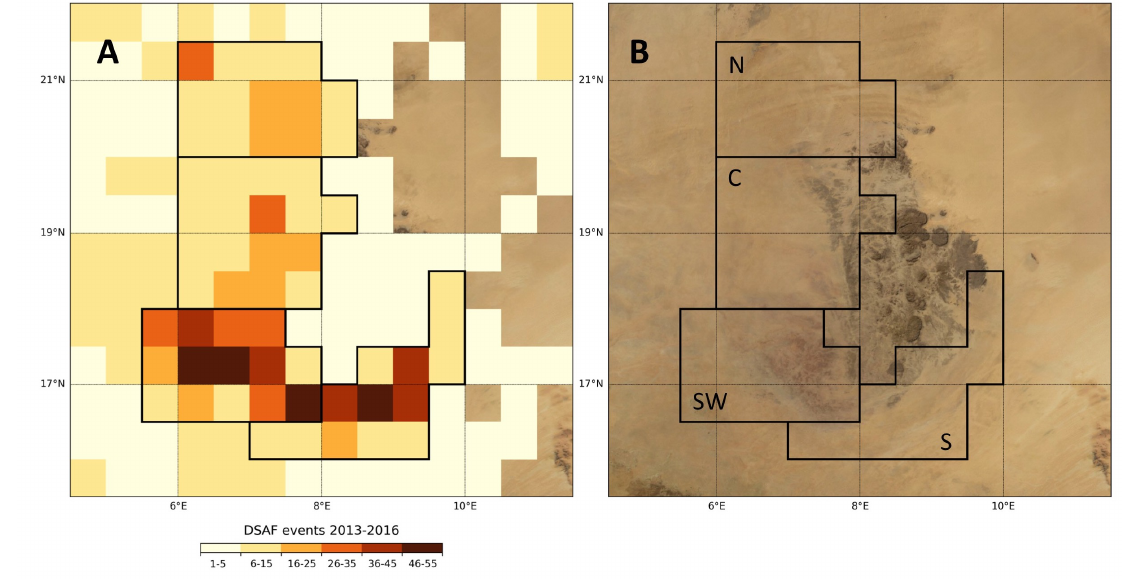
Figure 5. Total number of dust events for the Aïr Massif observed on the MSG Desert-Dust-RGB images between 2013 and 2016 and the division of the study area into four dust-hot-spot-zones ( A ); and true color image of the study area including the hot-spot zones ( B